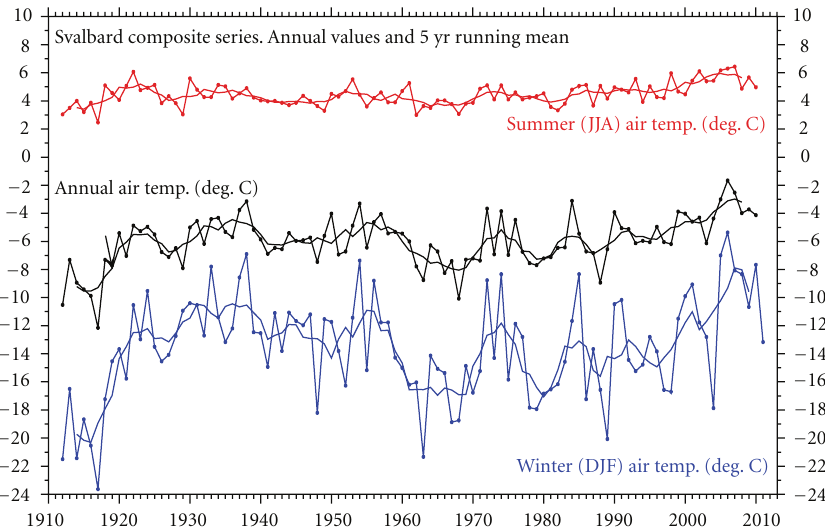
Figure 2: The Svalbard temperature record 1912–2010, showing the mean annual air temperature (MAAT), the average summer temperature (JJA), and the average winter temperature (DJF). Thin lines show annual values, and thick lines show the simple 5yr average (extracted from